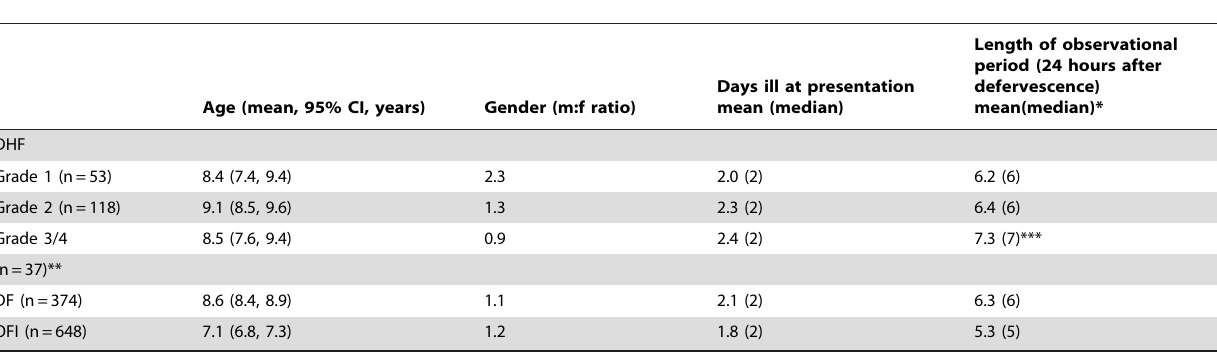
Table 1. Study sample characteristics, in the total sample and by final